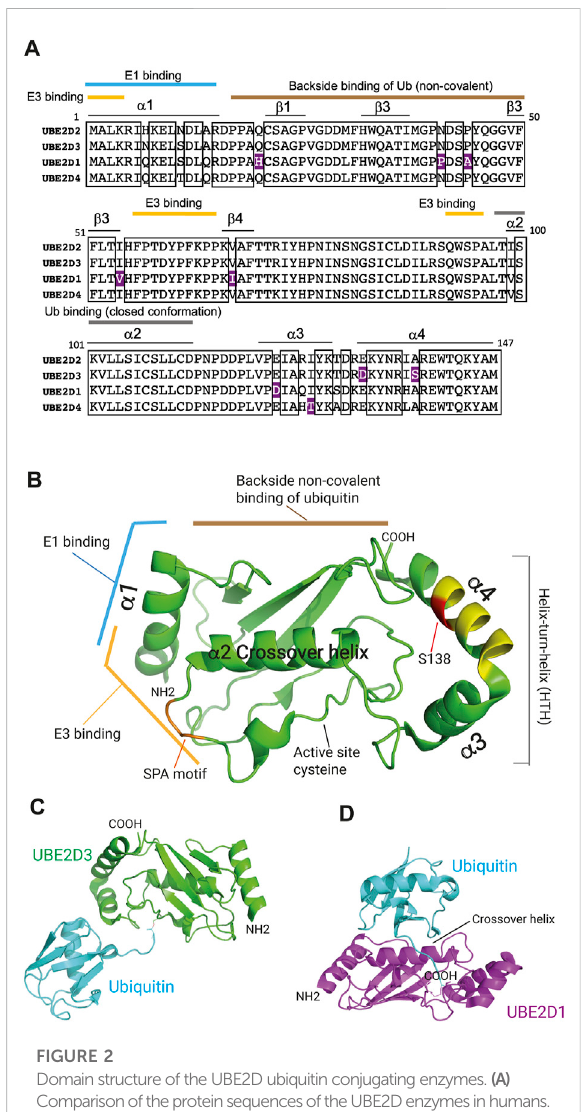
DomainstructureoftheUBE2Dubiquitinconjugatingenzymes. (A) ComparisonoftheproteinsequencesoftheUBE2Denzymesinhumans. Boxes indicate the sequences that are identical in all four enzymes. Residues that are divergent in only one of the UBE2D proteins and conserved in the other three are highlighted in purple. UBE2D2 and UBE2D3show the greatestsimilarity, diverging from one another in only three residues (98% identity), whereas UBE2D1 shows the largest divergence from the sequences of the other three enzymes (4%). The positions of α -helices and β -sheet regions are also shown, as are the regionsthatmediatebindingoftheE1andE3enzymes,thenon-covalent backside binding of ubiquitin (Ub), and the interaction with the α 2 crossover helix, which generates the closed active conformation of ubiquitin. (B) Locationofbindingdomainsinthe3-dimensionalstructure of UBE2D3 (Stewart et al., 2016). The positions of the residues that are hypervariable in UBE2D3 in Percomorph fi sh species (Figure 4) are indicated in yellow and the position of the amniote-speci fi c UBE2D3- Ser138residueisshowninred.TheSPAmotifiscolouredorange.Image waspreparedbyvisualisingPDB:2FUHusingPyMol(v2.5.4). (C) Structure of the UBE2D3-ubiquitin conjugate with ubiquitin in the extended con fi guration(PDB3UGB).UBE2D3andubiquitinarecolouredgreenand cyanrespectively. (D) StructureoftheUBE2D1-ubiquitinconjugatebound to the RNF4 E3 ligase (not shown) with ubiquitin in the closed “ active ” con fi guration generated by interaction with the α 2 crossover helix of